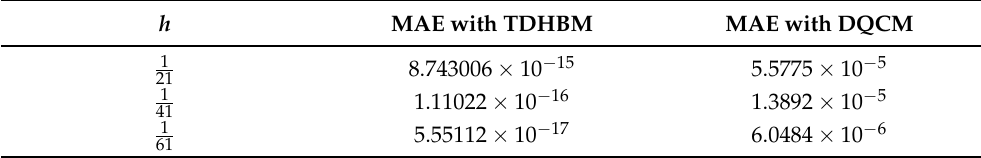
Table 6. Comparison of the MAE on Problem (25) with r =